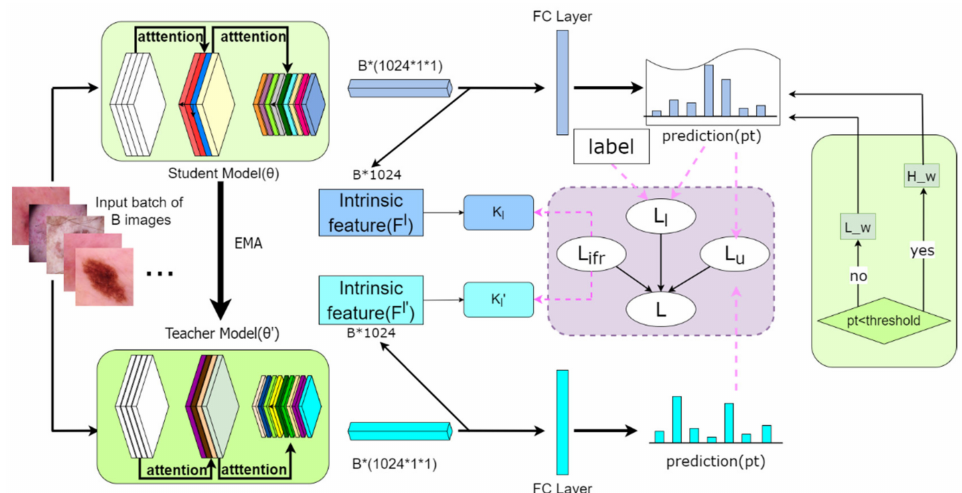
Figure 1. Overview of our semi-supervised framework for medical image classification. The teacher’s weight θ (cid:48) is updated to the exponential moving average (EMA) of the student’s weight θ . The objective function of optimizing the student model includes the supervised loss (L l ) on the marked set and two unsupervised consistency losses (L ifr and L u ) on the unlabeled set and the marked set, respectively. By minimizing the three losses, the whole framework can fully mine the features of labeled samples and unlabeled ones, thereby accurately classifying them.